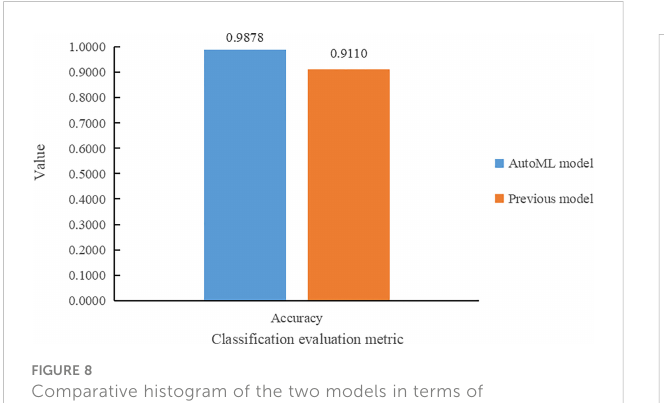
FIGURE 10 Comparative histogram of MSE for the two models in the leaf area regression